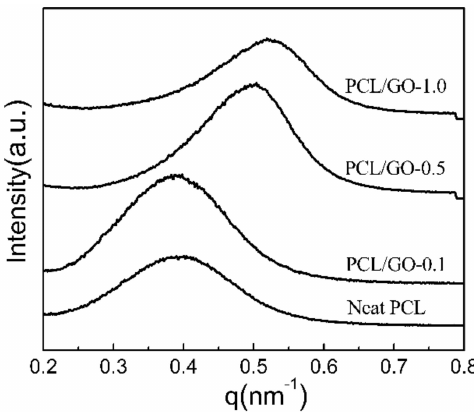
Figure 1. 2D-SAXS patterns of neat PCL and its nanocomposites: ( a – d ) 5 days; ( e – h ) 50 days. ( a , e ) Neat PCL; ( b , f ): PCL/GO-0.1; ( c , g ) PCL/GO-0.5; ( d , h ) PCL/GO-1.0.